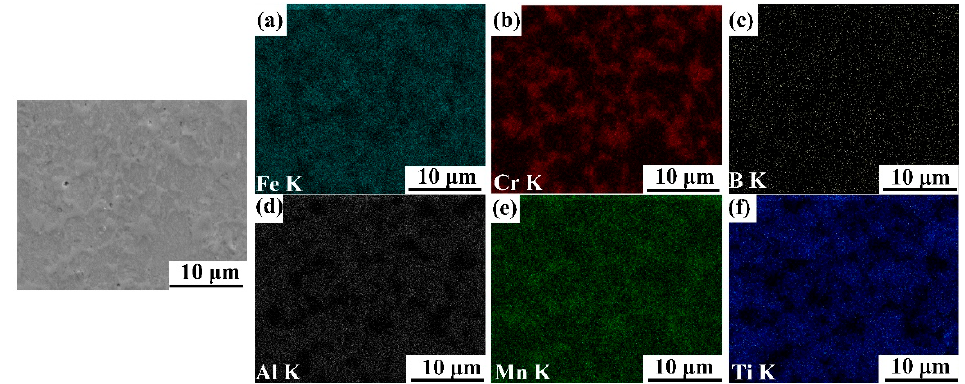
Figure 4. SEM image of 20 vol.%TiB 2 /Fe-15Cr-10Mn-5Al composite and elemental maps showing the distribution of ( a ) Fe, ( b ) Cr, ( c ) B, ( d ) Al, ( e ) Mn, and ( f ) Ti.